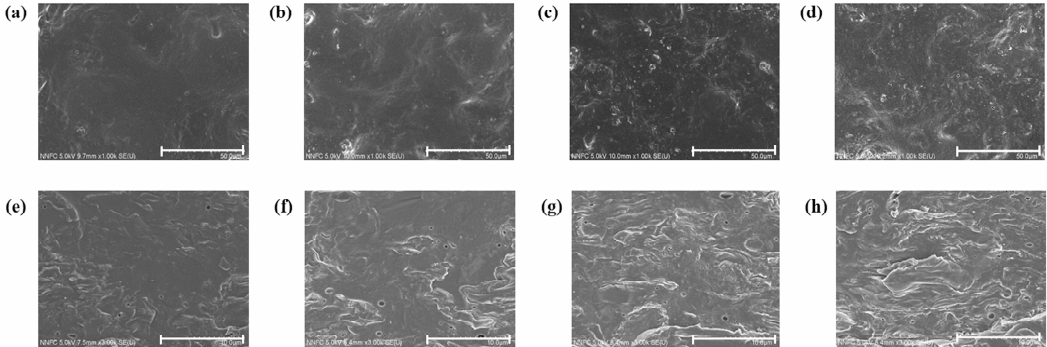
Figure 6. SEM images of the CJP films containing different concentrations of RPE: ( a – d ): surface of the films; ( e – h ): cross-section of the films; ( a , e ) CJP film; ( b , f ) CJP/0.25% RPE film; ( c , g ) CJP/0.5% RPE